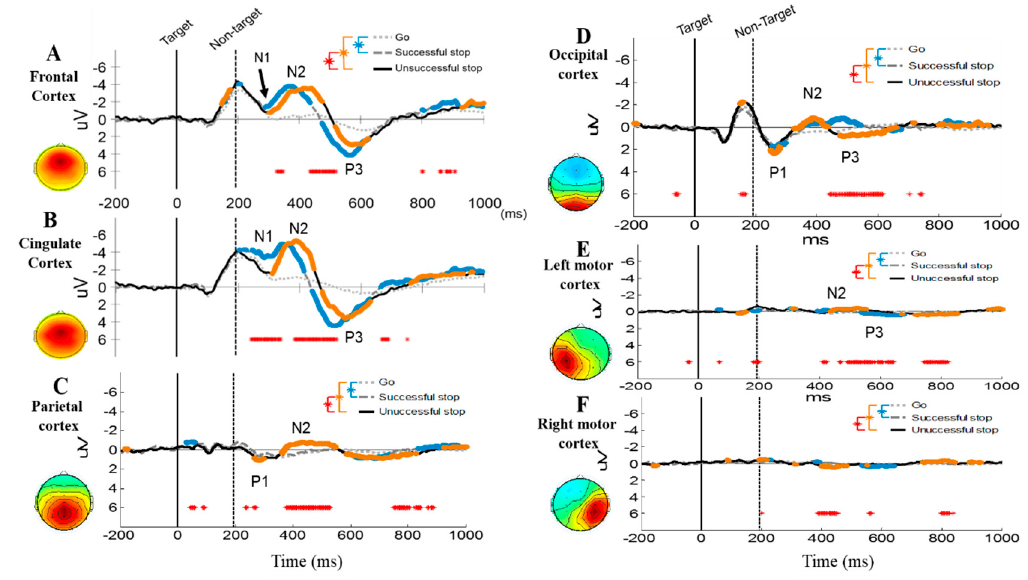
Figure 4. Averaged ERP of all subjects in the frontal cortex ( A ), cingulate cortex ( B ), parietal cortex ( C ), occipital cortex ( D ), left motor cortex ( E ) and right motor cortex ( F ) during successful go, successful stop and unsuccessful stop conditions with battlefield scenario. The ERP ( µ V) reveals on y -axis and time value of − 200 to 1000 millisecond (ms) shows on x -axis. The black vertical line shows go cue (target) and next vertical black dash line shows stop signal (non-target). The horizontal red areas show